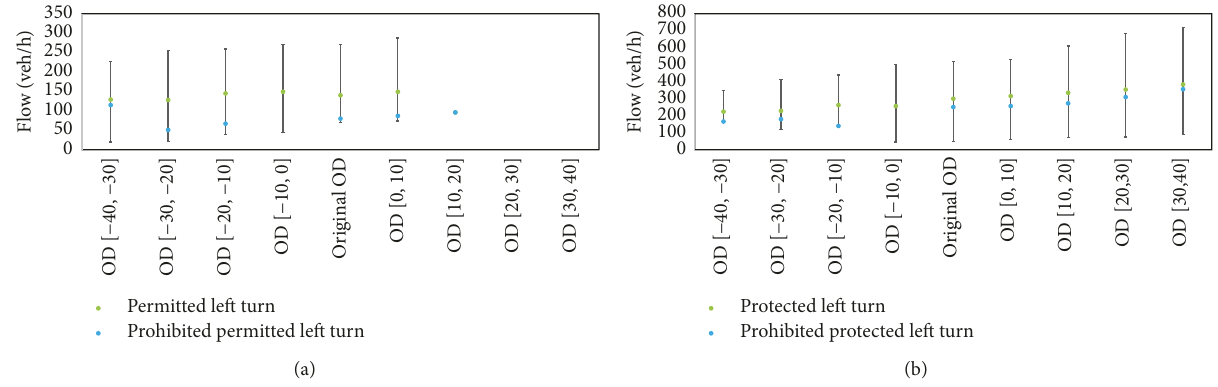
Figure 10: (a) Flow comparison between permitted left turns and prohibited/permitted left turns; (b) flow comparison between protected left turns and prohibited protected left